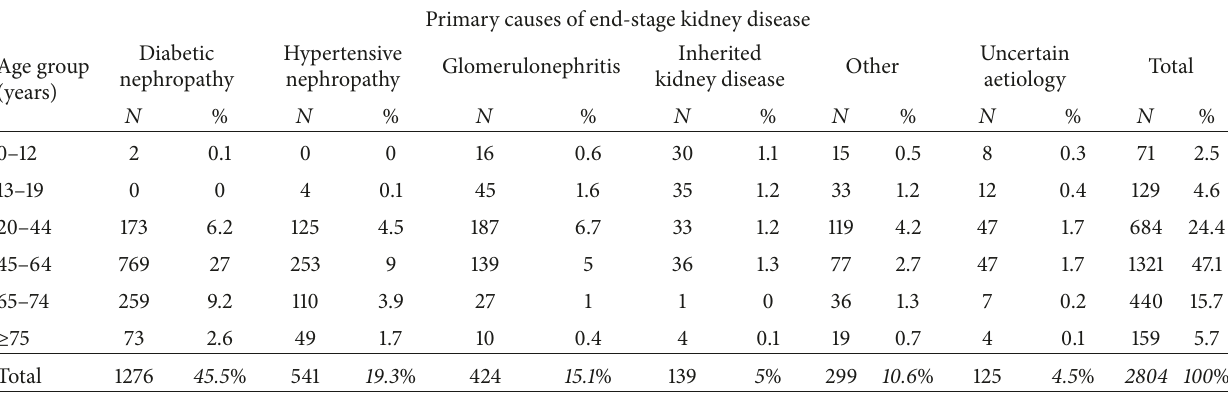
Table 1: Distribution of primary kidney diagnosis by age in ESKD patients